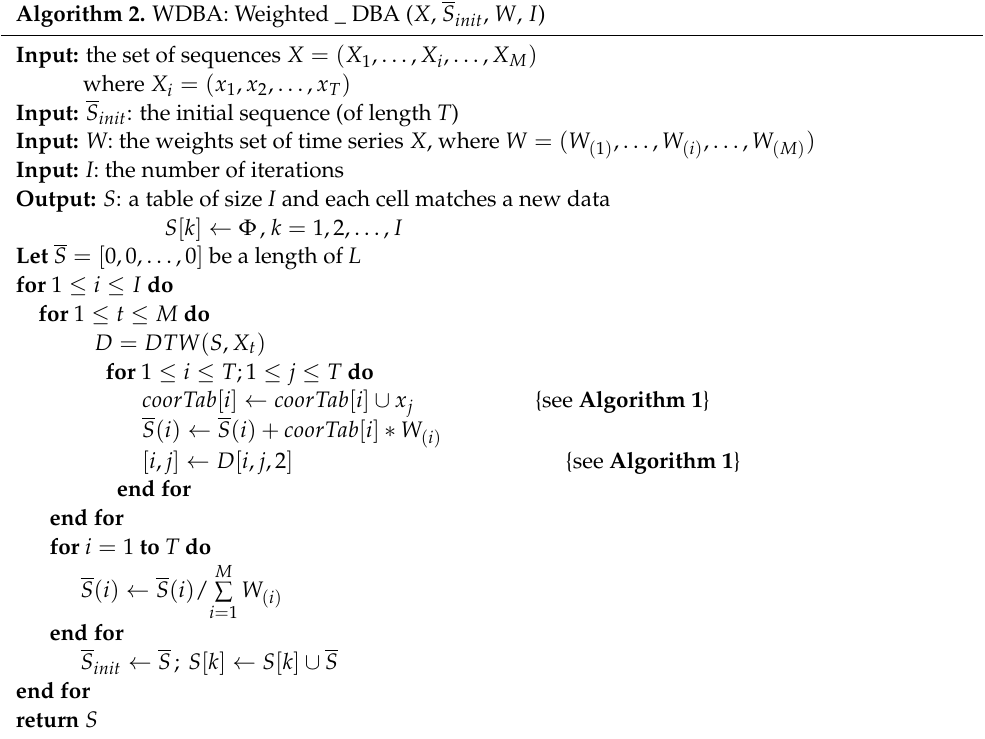
Algorithm 2. WDBA: Weighted _ DBA ( X , S init , W , I